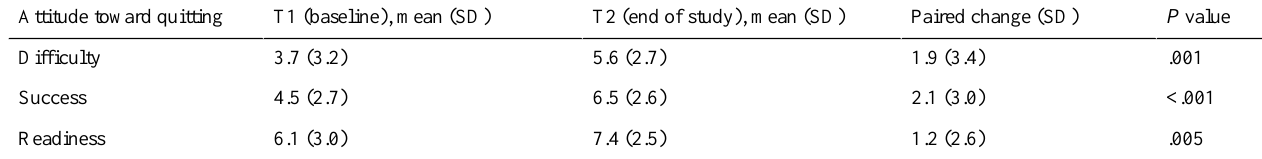
Table 3. Changes in attitudes toward quitting smoking. For paired change analyses, positive numbers are favorable.